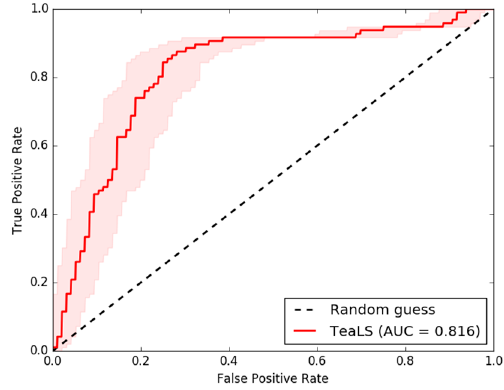
Figure 7. ROC plot and AUC score of land suitability for tea plantations.